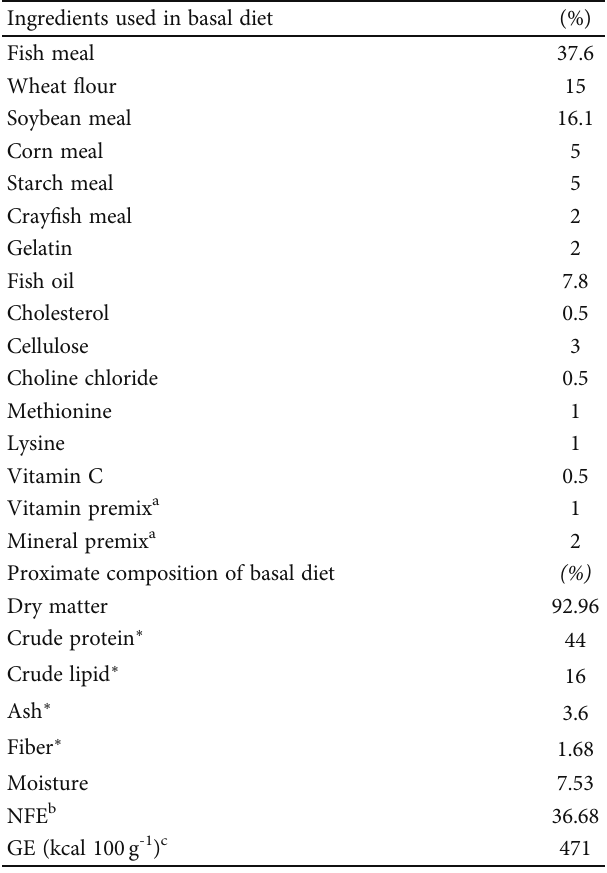
Table 1: Composition and proximate analysis of the basal diet. Ingredients used in basal